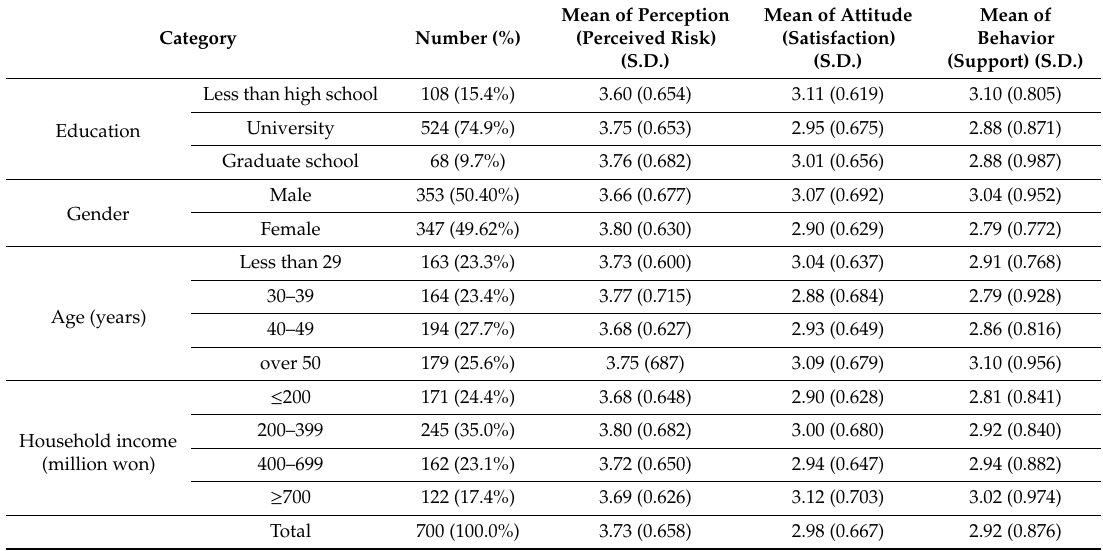
Table 3. Distribution of respondents and the mean values of perceptions, attitudes, and